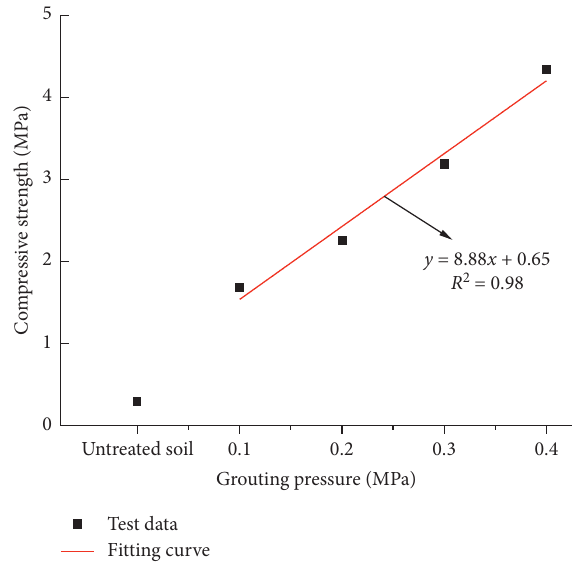
Figure 10: Variation of compressive strength with grouting